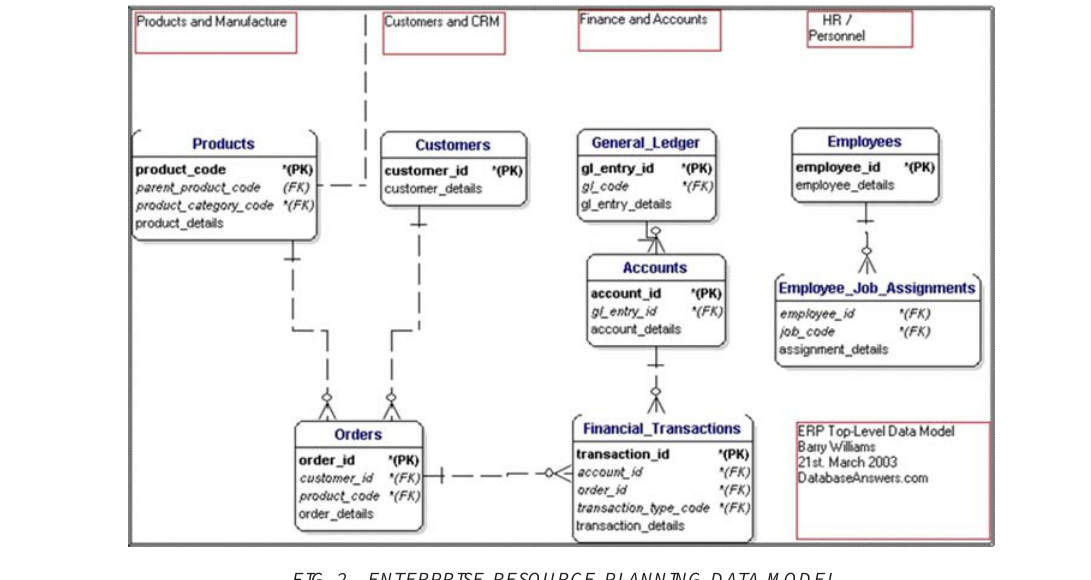
FIG. 2. ENTERPRISE RESOURCE PLANNING DATA